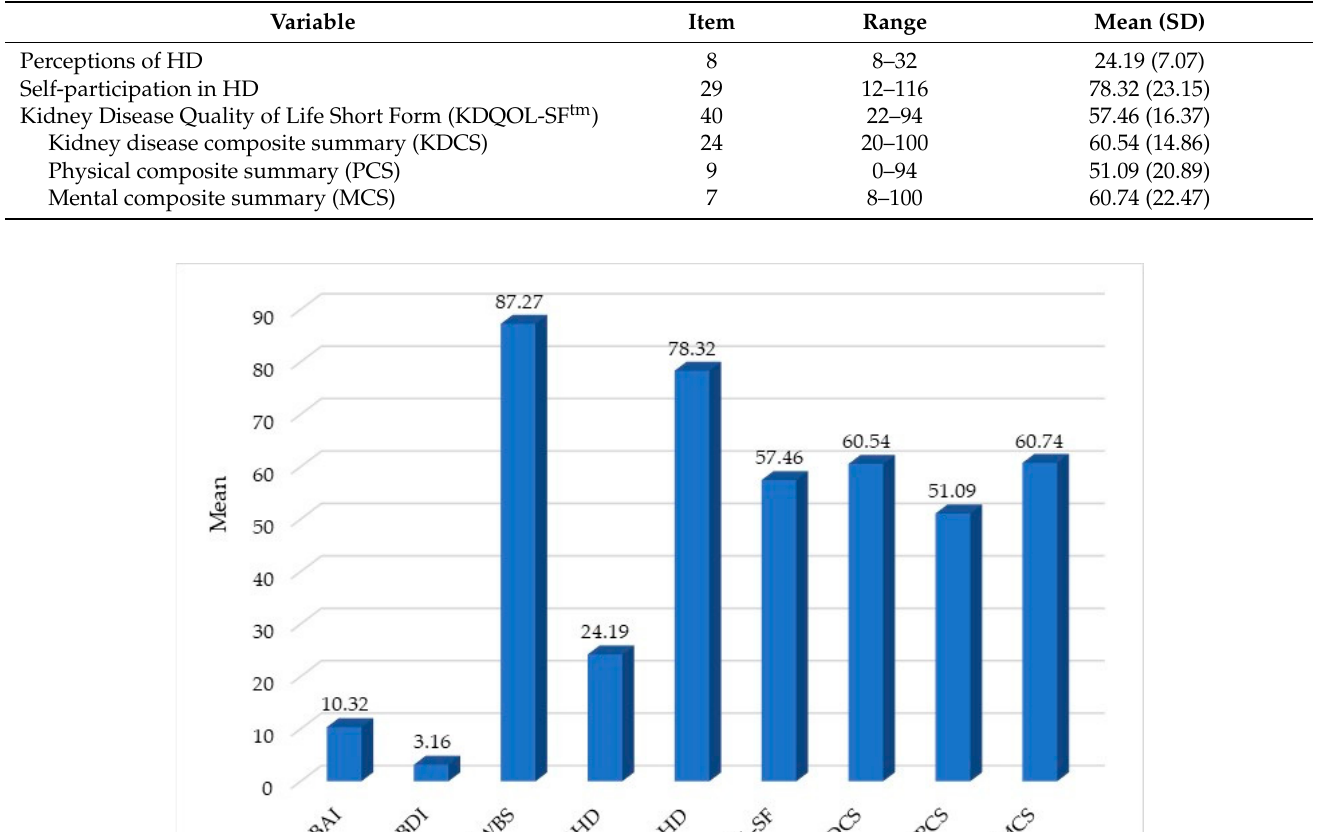
Table 4. Perceived feelings about hemodialysis, self-participation, and quality of life of hemodialysis patients (n = 298).